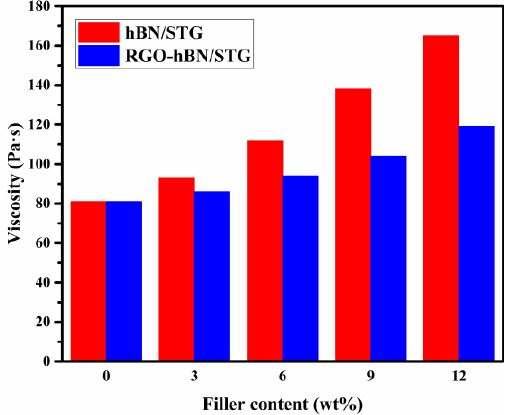
Figure 4. Viscosity of hBN/STG and RGO- hBN/STG with different filler contents .